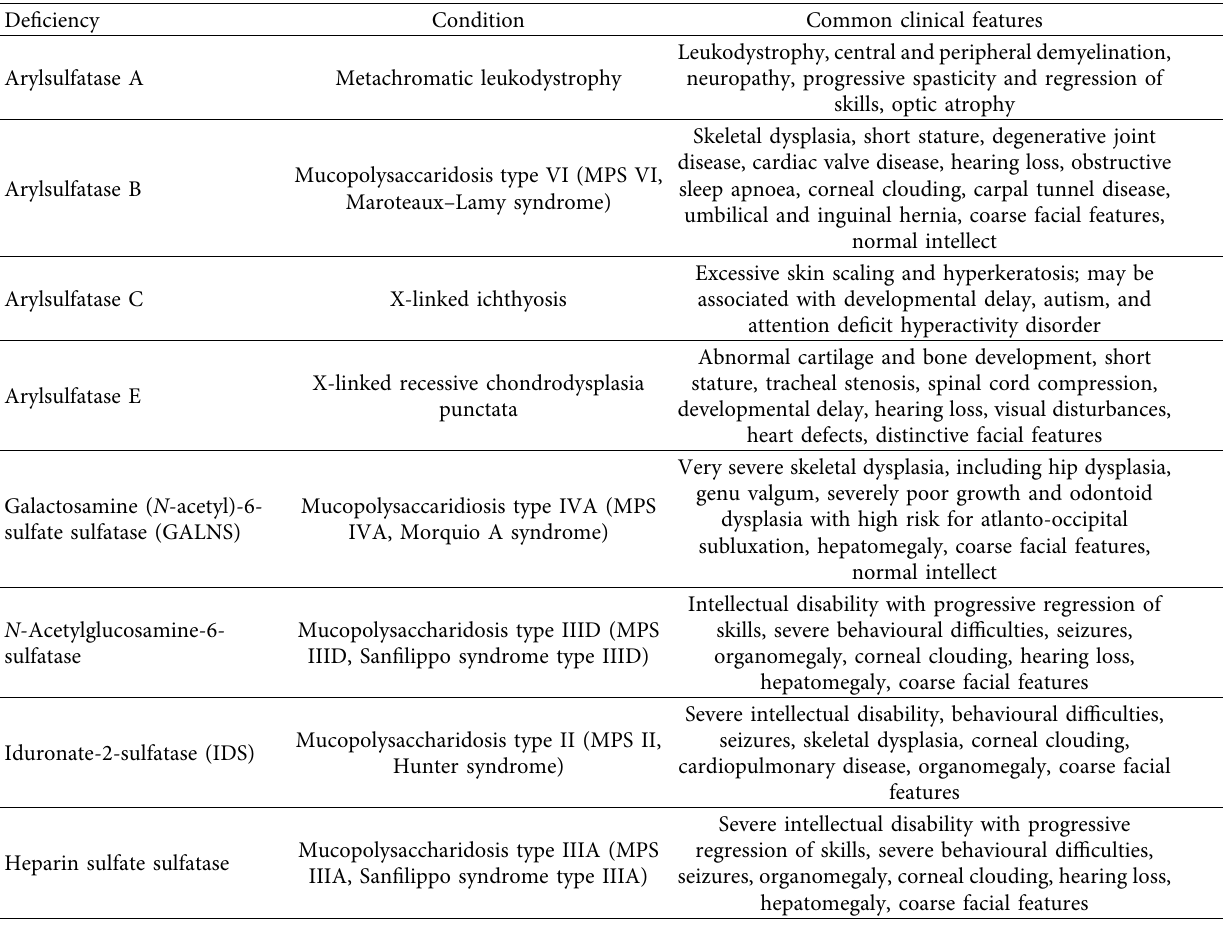
Table 1: Clinical disorders attributed to individual sulfatase deficiencies [3, 7, 10].